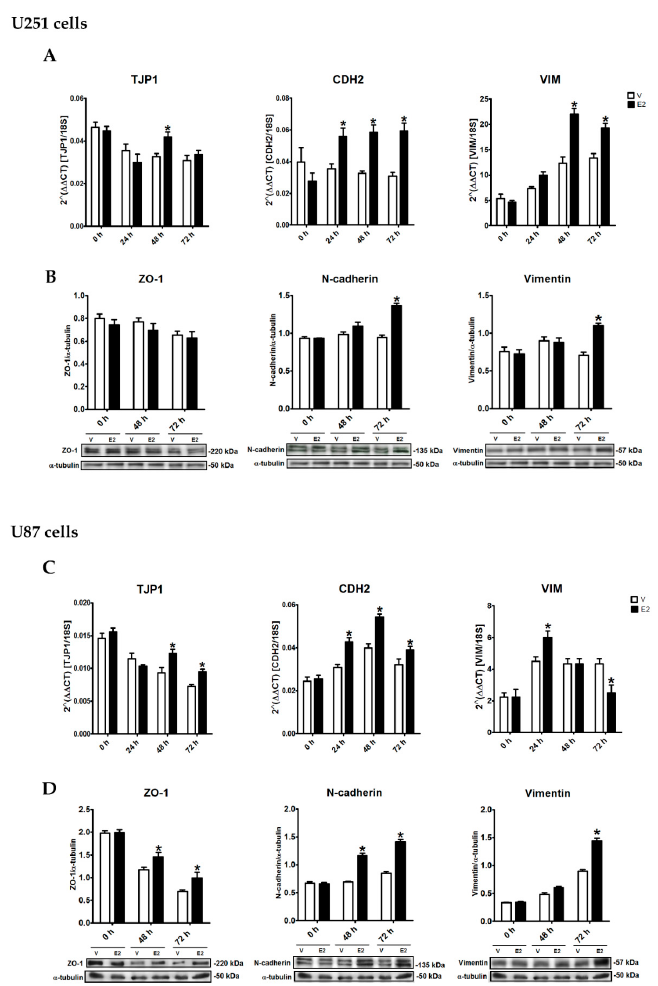
Figure 4. E2-regulated epithelial-to-mesenchymal transition (EMT) marker expression of human GBM-derived cells. ( A , B ) U251 and ( C , D ) U87 cells were treated with 17 β -estradiol (E2, 10 nM) and vehicle (V, 0.01% cyclodextrin) for 24, 48, and 72 h. ( A , C ) Epithelial gene (tight junction protein 1 (TJP1)) and mesenchymal genes (vimentin (VIM) and cadherin-2/N-cadherin (CDH2)) expression was quantified by RT-qPCR using the comparative method 2 ΔΔ Ct concerning the reference gene 18S rRNA. ( B , D ) Zonula occludens 1 (ZO-1), N-cadherin, and vimentin content was determined by Western blot. Densitometric analysis of EMT marker expression with their respective representative bands using α - tubulin as a load control showed that E2 increased EMT marker expression with different temporal